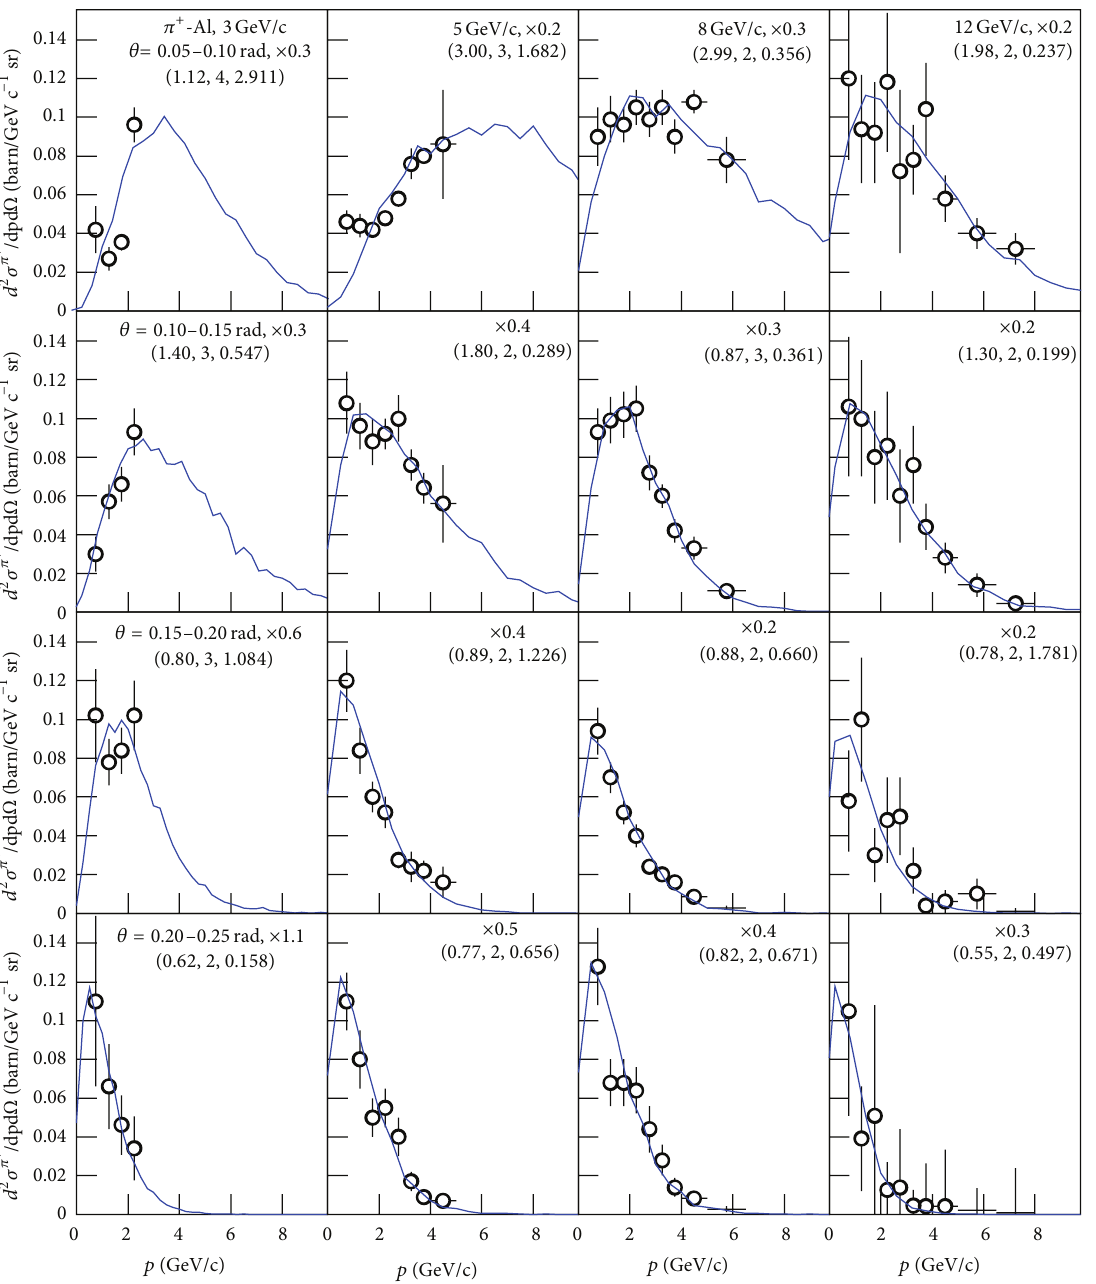
Figure 11: The same as Figure 1, but showing the results for 𝜋 + production cross sections in 𝜋 + -Al interactions.